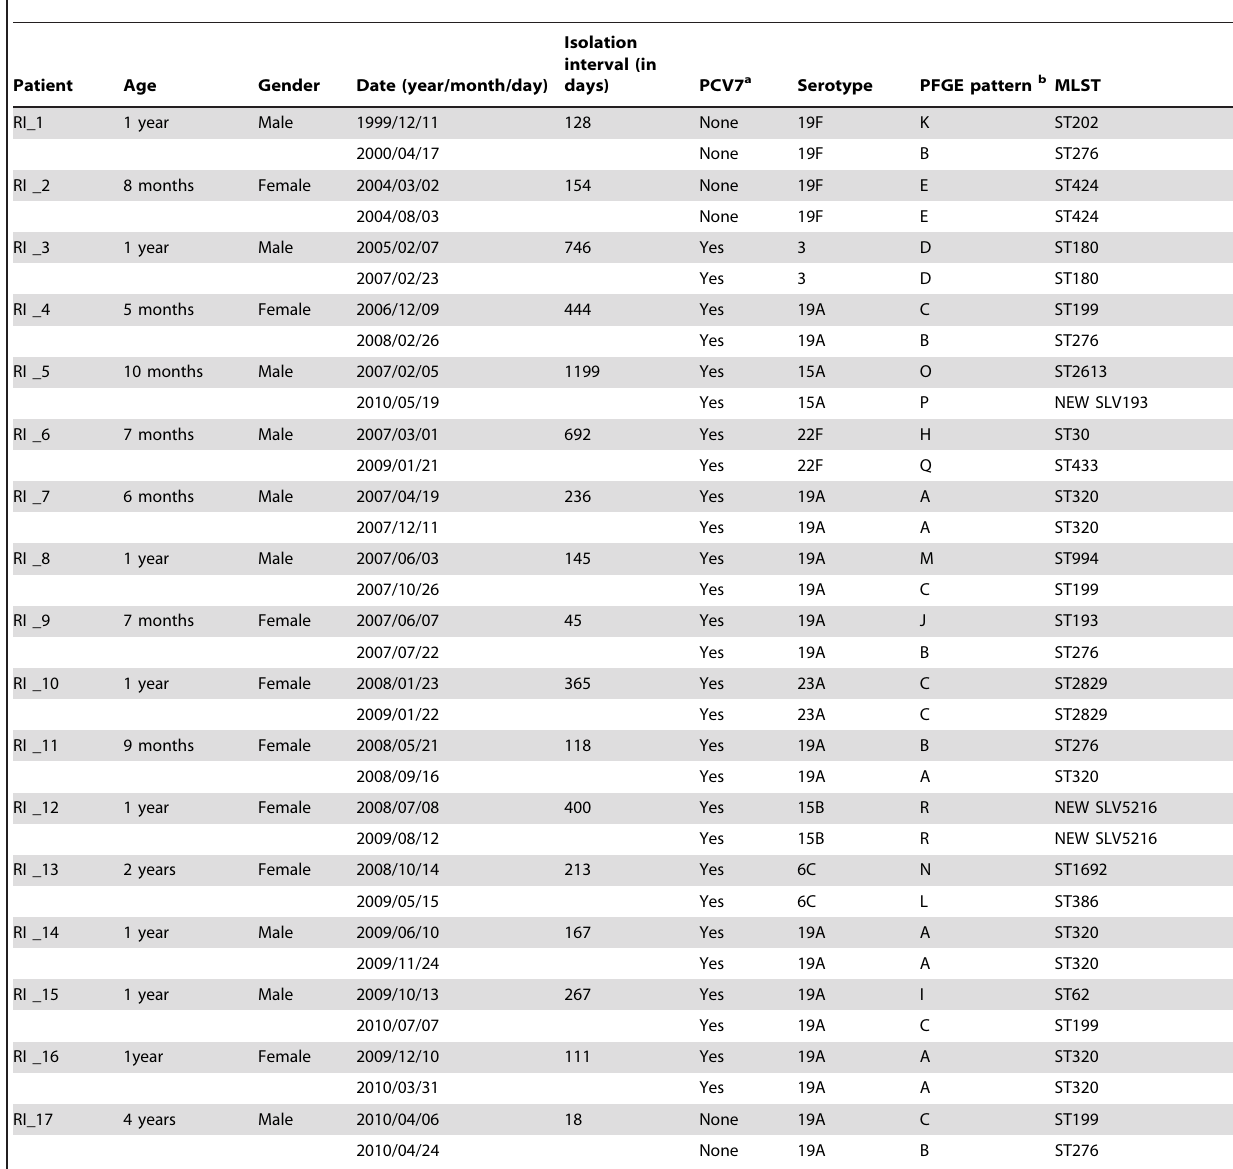
Table 4. Patients with reinfections caused by the same serotype as the initial infection.